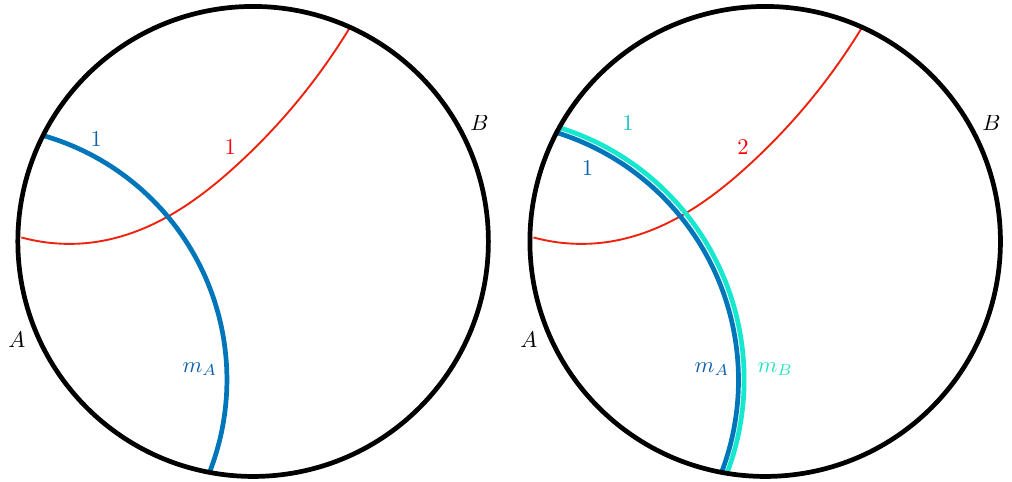
Figure 2 . Two different normalizations which count the number of threads (bell pairs) and thread endpoints (qubits) respectively. For the remainder of this paper we will adopt the latter convention as it more easily generalizes to the multipartite